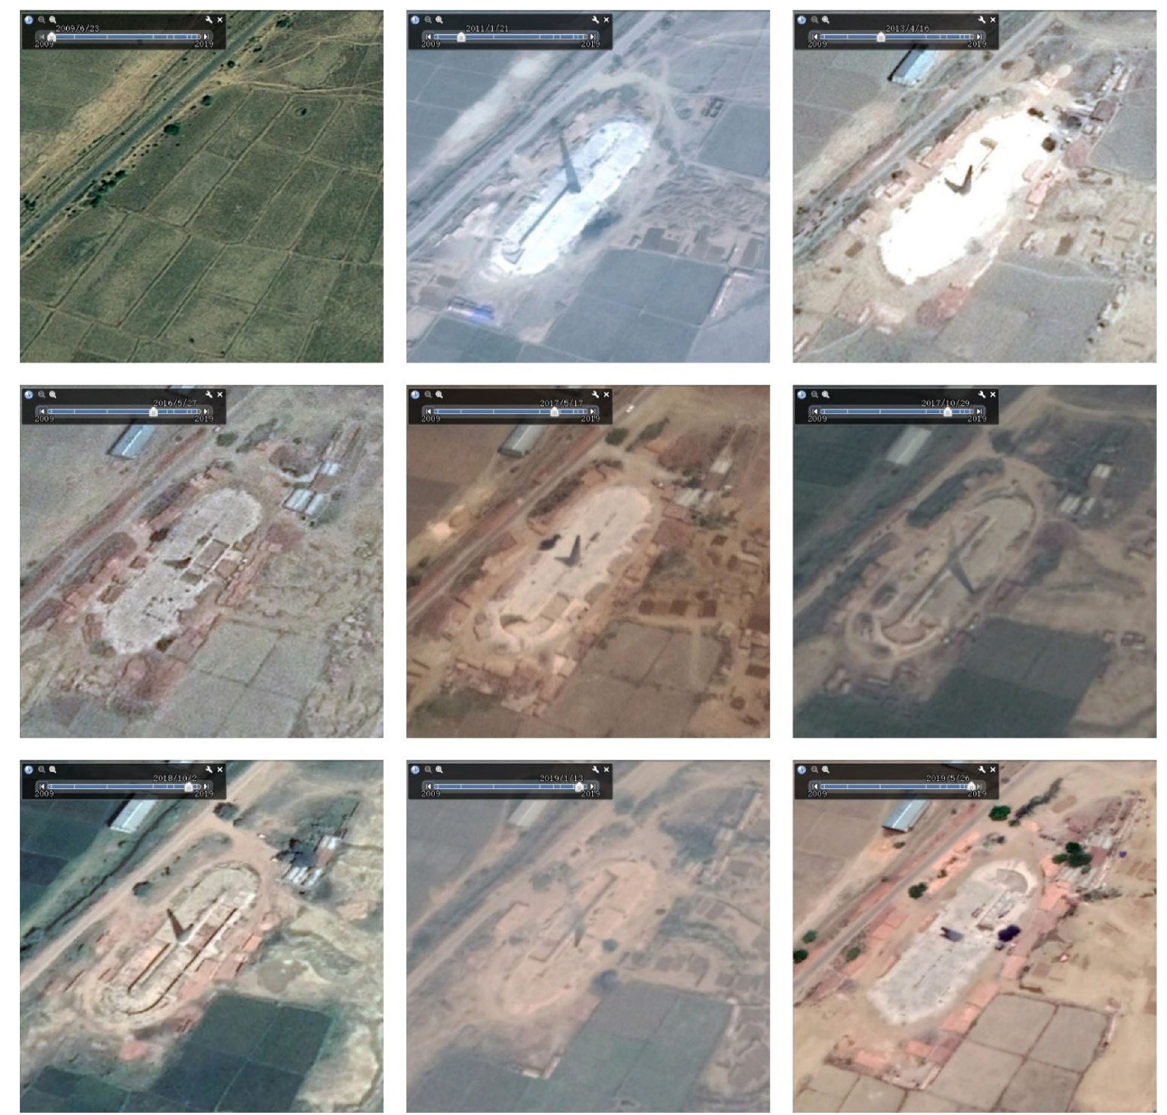
Fig. 1 The historical satellite imagery in the Google Earth Engine platform of the Bull ’ s Trench brick kiln mapped at 24°41 ’ 15 ” N, 84°30 ’ 24 ” E (Bihar, India). Data from Google, © 2021, CNES/AIrbus, Maxar Technologies. This kiln has not been built in the earliest image of this location (acquired on June 23, 2009), but had been built by the time the image dated January 21, 2011 was acquired; this kiln was inferred to be built between these two dates. The rest of the images illustrate how the same kiln appears throughout the satellite record in Google Earth, through to the latest date — 26 May 2019. Note that the temporal frequency of kiln capture increases over time as the use of VHR satellite imagery becomes more common